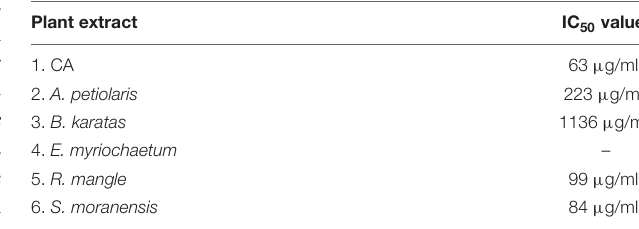
TABLE 2 | IC 50 values of plant extracts obtained from G6Pase system inhibition